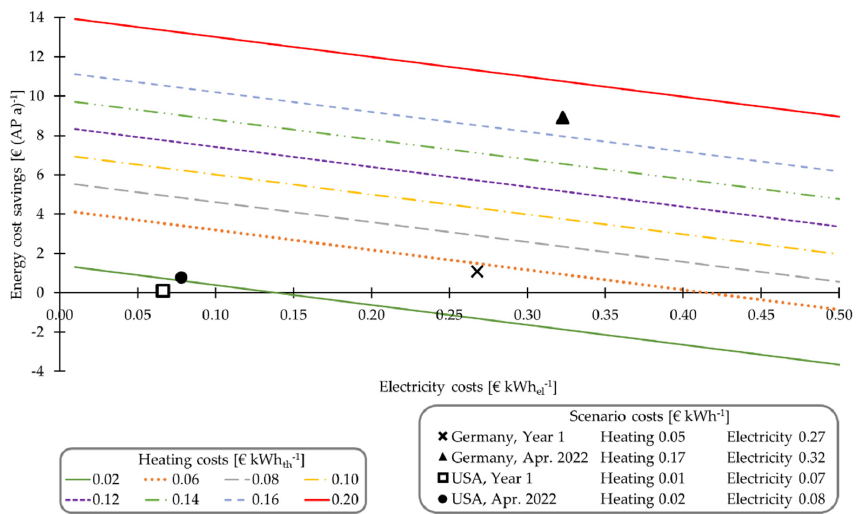
Figure 9. Annual energy cost savings [EUR (AP a) − 1 ] for various scenarios concerning electricity and LNG costs [EUR kWh el,th − 1 ]. The annual reduction quantities consider the 4140 animal places (AP) for piglet rearing in the barn. The calculations are based on the electrical energy consumption for the heat recovery Q HR,el (41,888 kWh el ) and heat recovered Q HR,th (290,414 kWh th ) of trial year 1 (17 December 2019–15 December 2020). GER = Germany, USA = United States of America. In April 2022, with a LNG price of 17.37 ct kWh th − 1 and electricity costs of 32.27 ct kWh el − 1 , savings of EUR 36,940.49 could be achieved in Germany. In